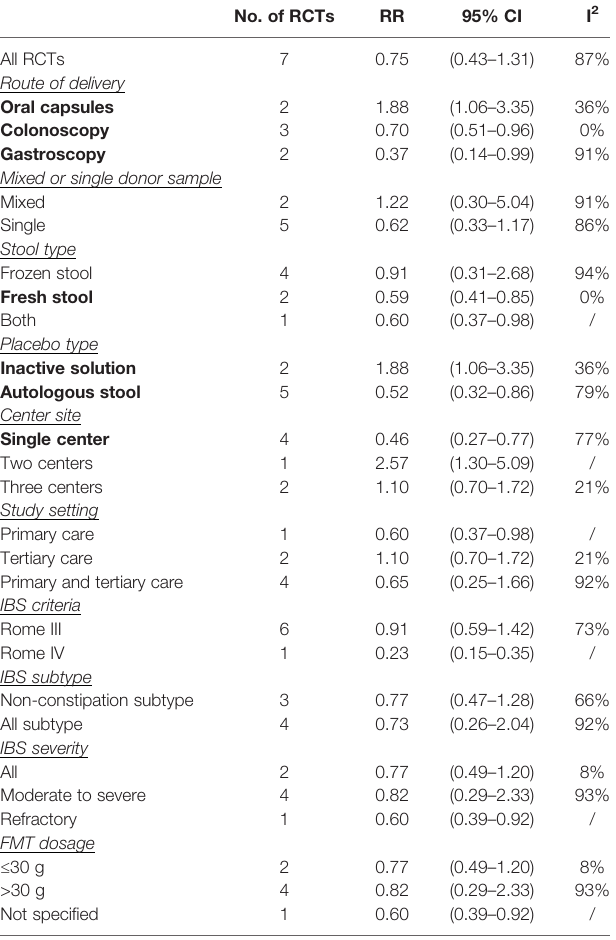
TABLE 2 | Subgroup analyses comparing FMT with placebo in IBS.